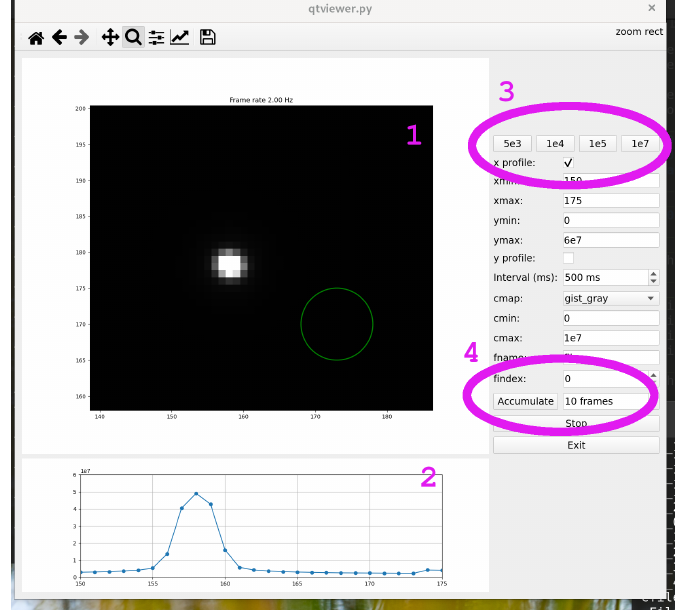
Figure 1. Graphical control interface of the JUNGFRAU detector developed for our experiments. (1) The main panel shows an enlarged image of the direct beam. The centre of the detector surface is shown as a green circle. (2) The one-dimensional beam profile below enables fast focussing of the diffraction pattern on the detector surface by minimising the standard deviation of the beam profile. The panel on the right sets the dimensions of the profile and the contrast of the main panel. (3) The top row has presets for the contrast. (4) The Accumulate button takes a